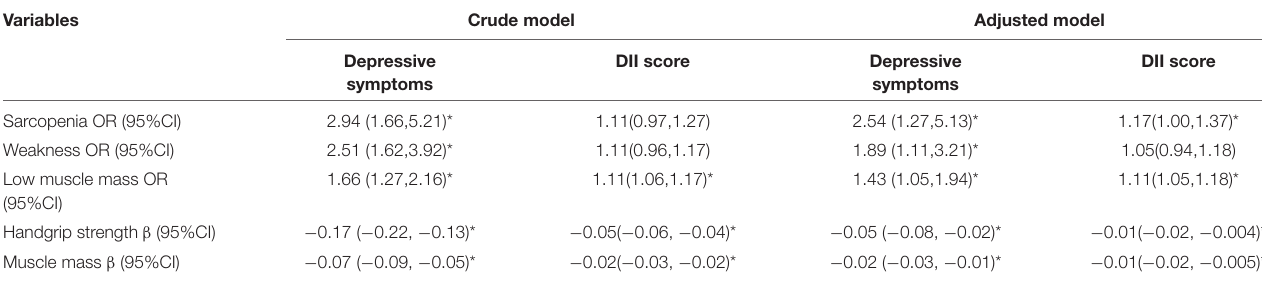
TABLE 3 | Relationships between depressive symptoms, DII, and sarcopenia.